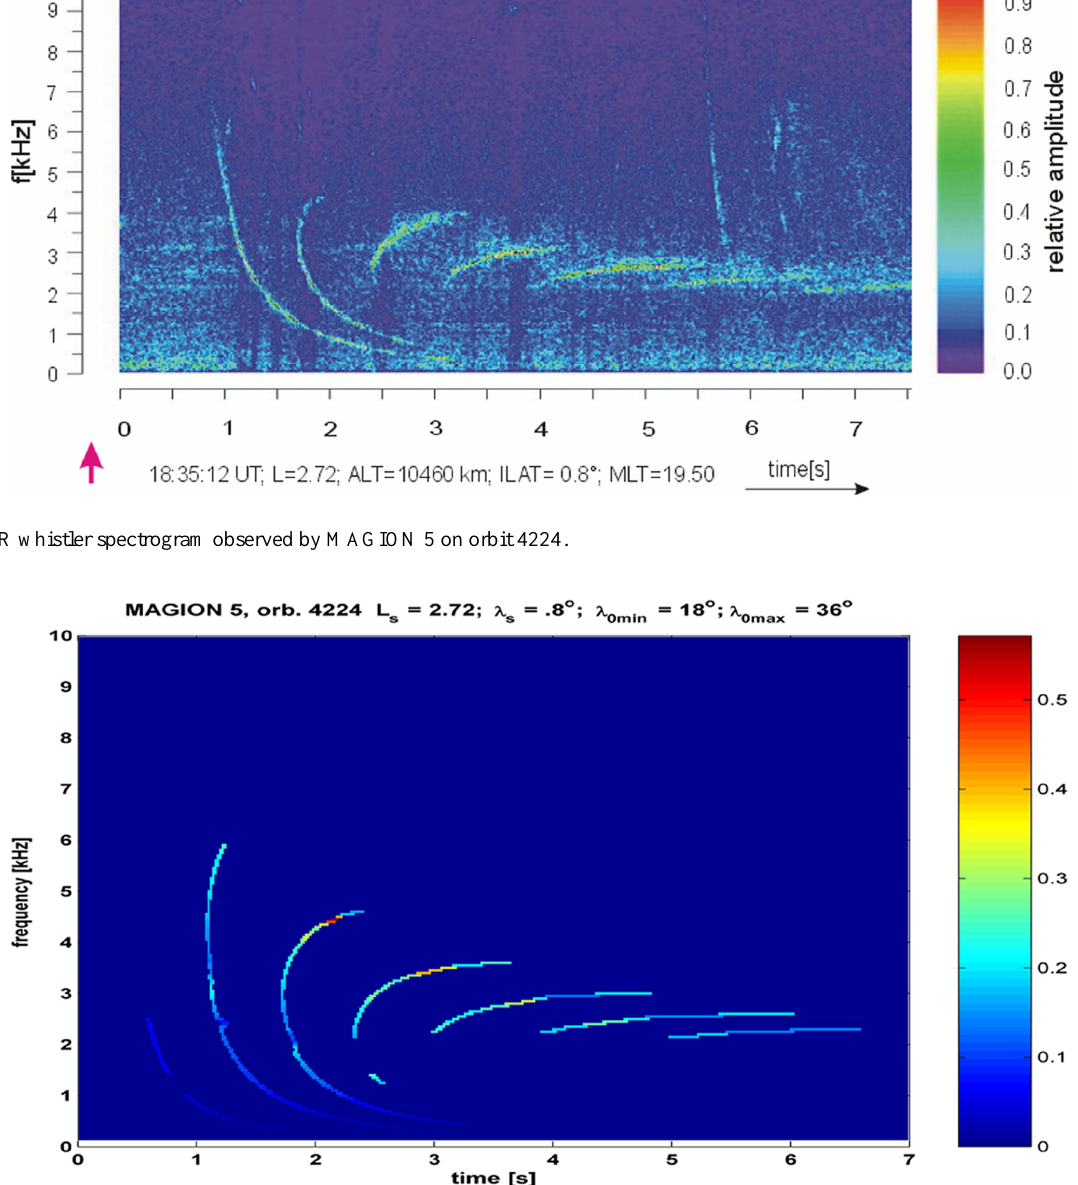
the lengthening of the ray paths. Note that the initial traces